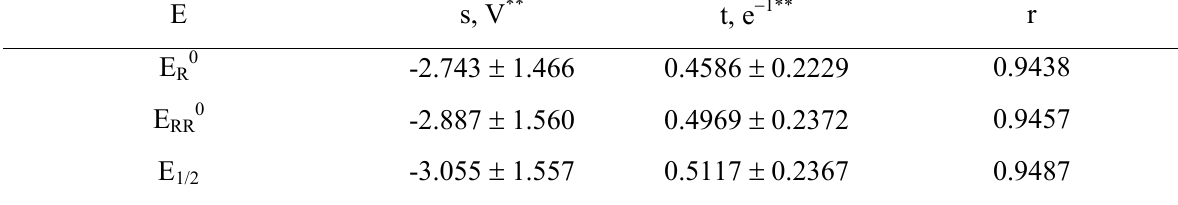
values ( vs saturated Hg 1/2